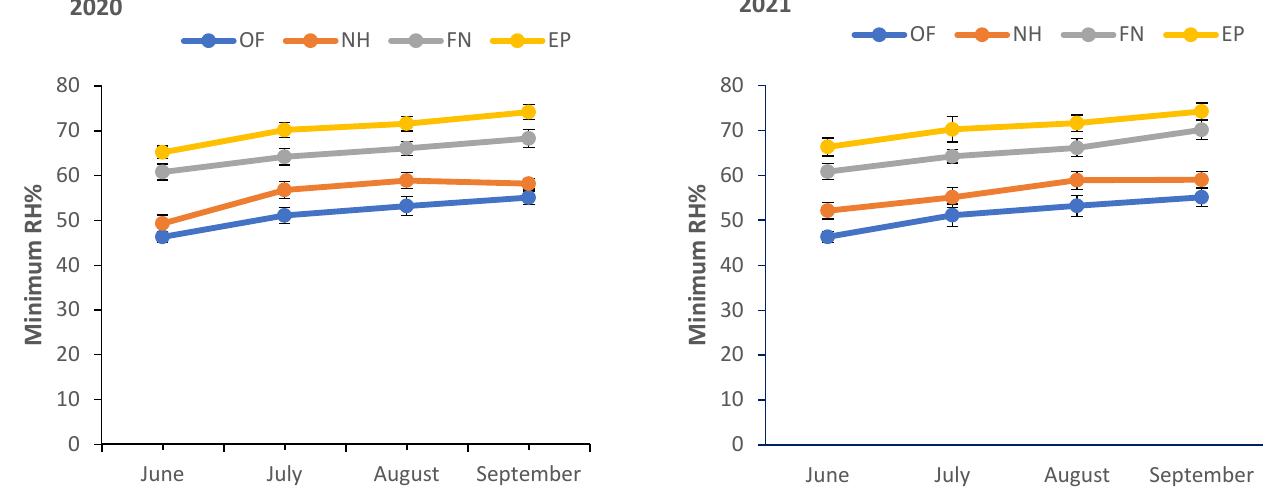
Figure 6. Average monthly maximum relative humidity percentage (RH%) during the experiment periods of 2020 and 2021 seasons, registered in the open field (OF), net house (NH), net house with fogging (NF, operating 6 S/36 S from 10 a.m. to 4 p.m.) and evaporative cooling under plastic house (EP). Standard error of the means was derived three biological replicates.